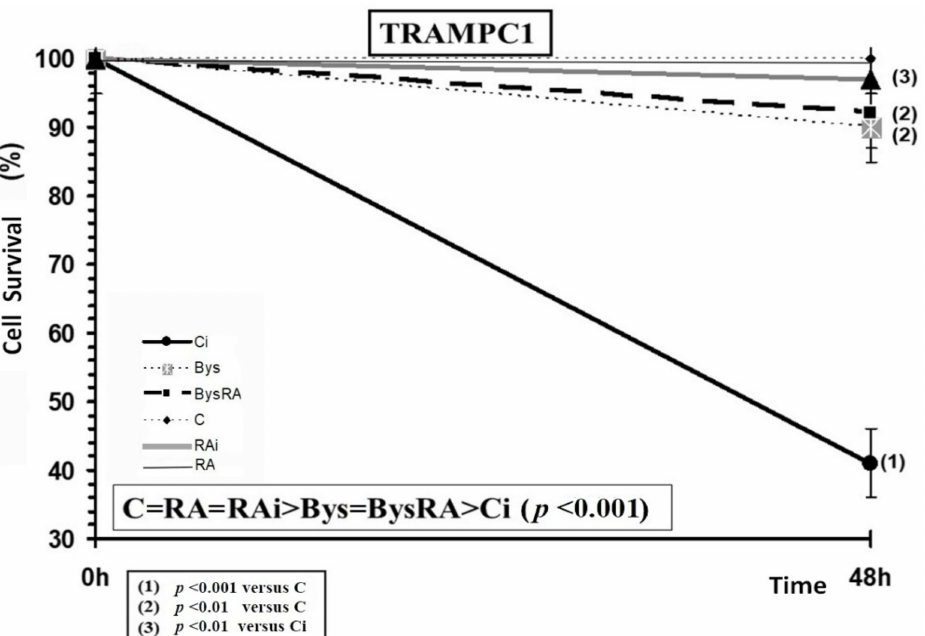
Figure 7. Cell survival of TRAMPC1 cells irradiated to 20 Gy of X-rays after 48 h of incubation (C, control; RA, treated with rosmarinic acid; Ci, irradiated control; RAi, irradiated, previously treated with rosmarinic acid; Bys, treated with irradiated cell culture medium; BysRA, treated with irradiated cell culture medium and with rosmarinic acid). Data are the mean and standard error of eight independent